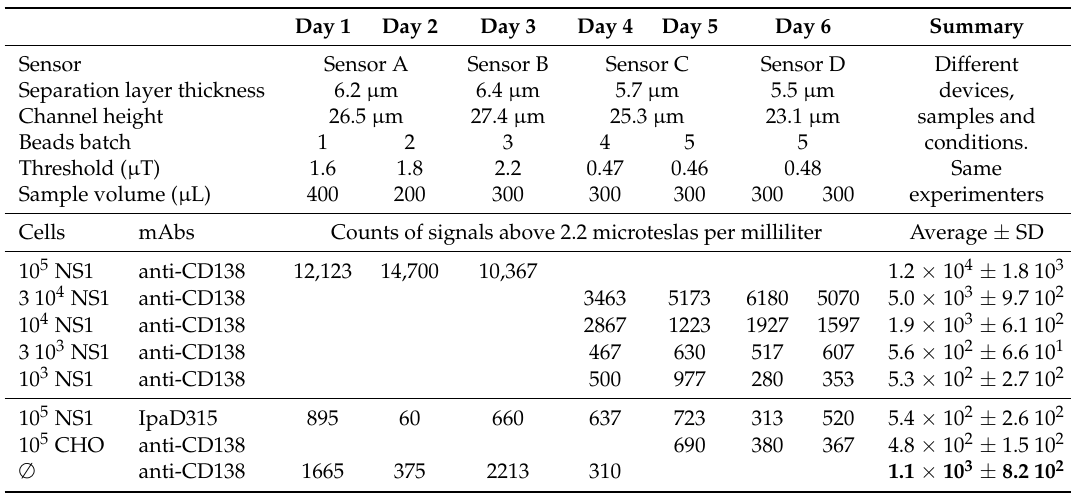
Table 2. Experimental conditions of the seven experiments. The threshold of each experiment is defined as the lowest detectable signal (with a signal to noise ratio at 3). Results are given as a number of events above 2.2 µ T detected per milliliter of sample. The average count is given with its standard deviation (SD) for each sample. Control samples are presented at the bottom of the table, separated from positive samples. The highest count in negative samples, in bold, is obtained for anti-CD138 beads in PBS for which the average value added to three standard deviations gives 3.6 10 3